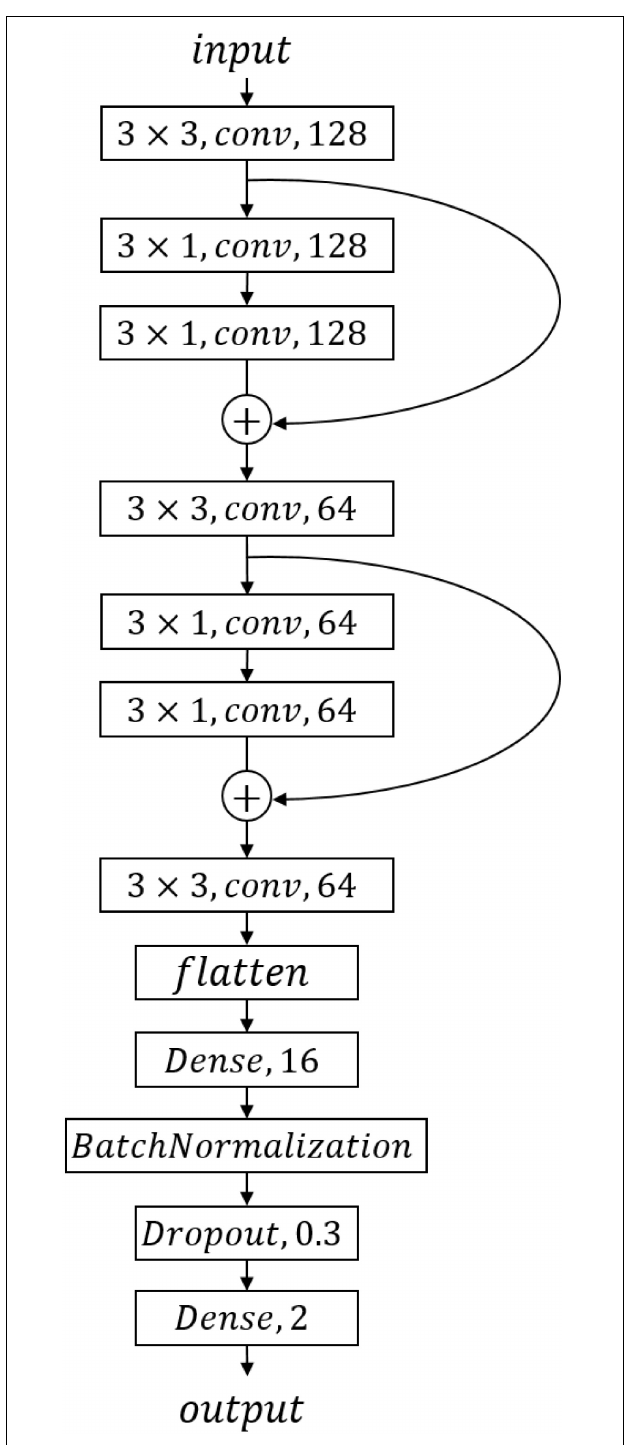
FIGURE 2 | Convolutional neural network structure and parameters.